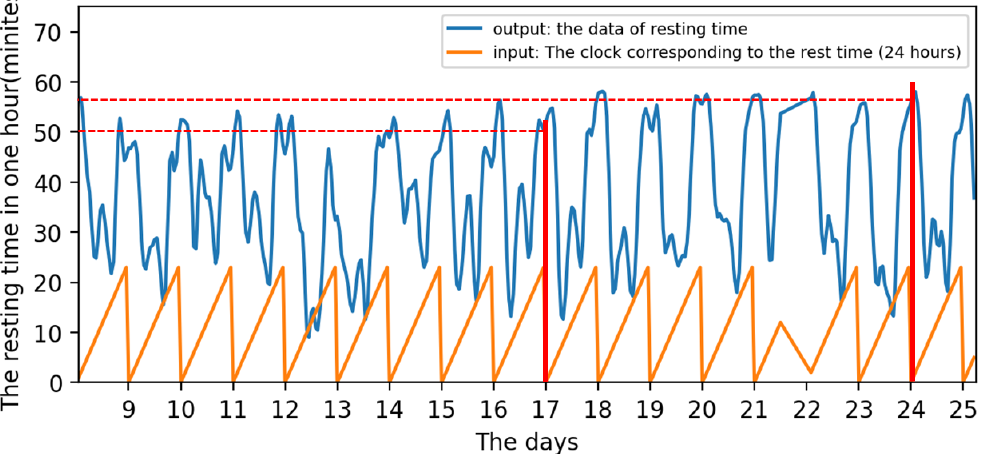
Figure 11. The input and output based on the LSTM